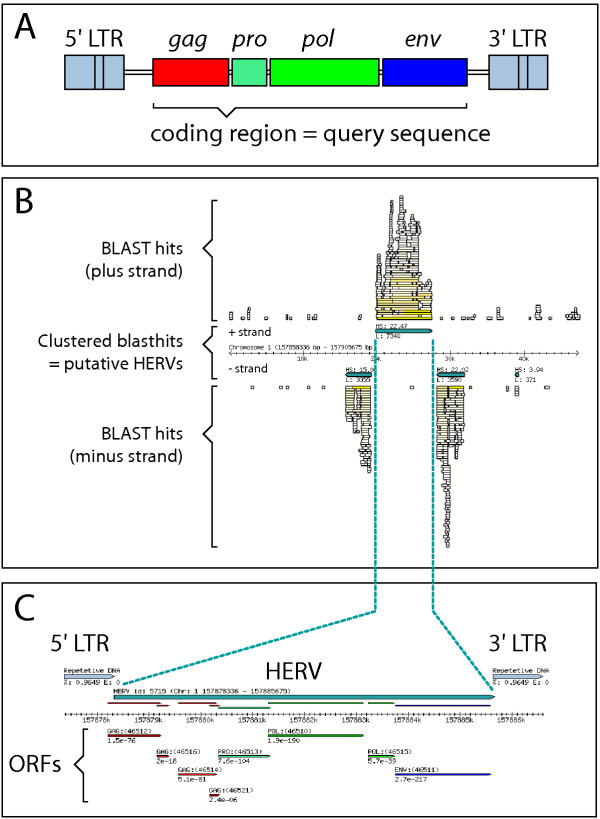
A: Genomic organization of simple retroviruses when present as a provirus (DNA) integrated in the host genome. The regulatory long terminal repeats (LTRs) flank the internal three major genes gag, pol and env. A fourth gene pro is present between gag and pol for some retroviruses, while part of either gag or pol in others. B: Individual BLAST hits (white and yellow boxes) on either strand of the human genome were clustered into HERV regions (blue boxes) or discarded by using a score function. Finally, only HERV regions with at least one retroviral ORF were kept (see Materials and Methods). In the example illustrated HERV ID 5715 was presumably inserted into an existing HERV locus with the opposite orientation. HERV ID 5715 is located in the first intron of the CD48 gene (antisense direction) and is also known as HERV-K18 or IDDMK1,222. C: HERV ID 5715 with graphical vORF annotation. Putative LTR structures are indicated and all ORFs (stop-codon to stop-codon fragments above 62 aa) are mapped and annotated by homology criteria